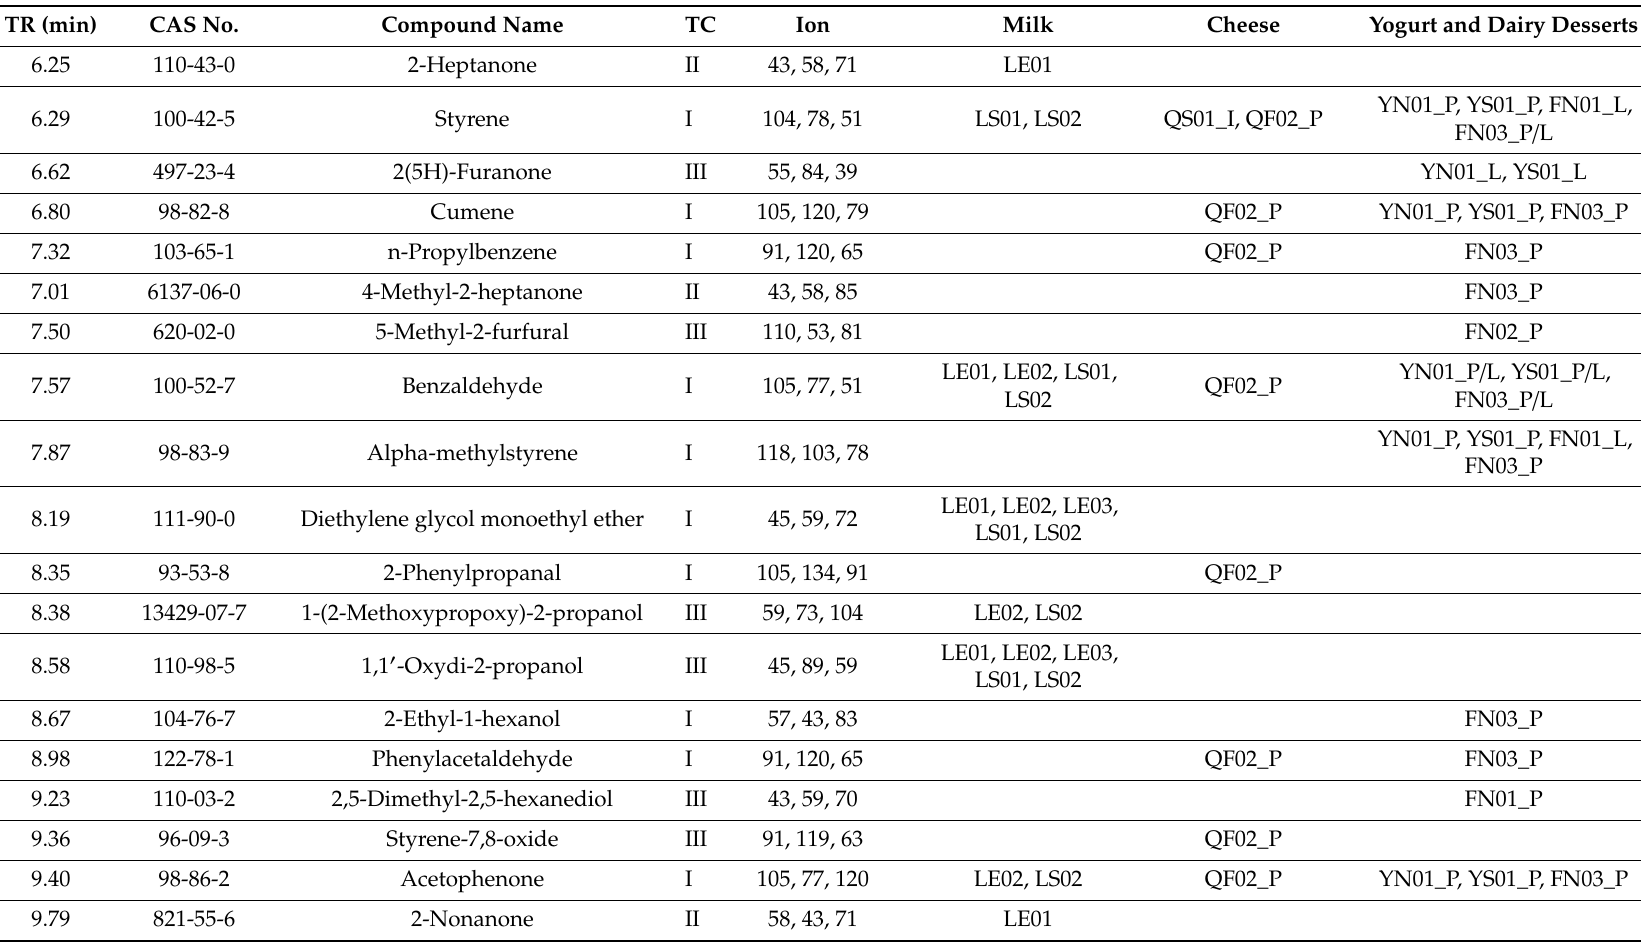
Table 2. Compounds identified in packaging materials and their level of toxicity (TC) according to Cramer